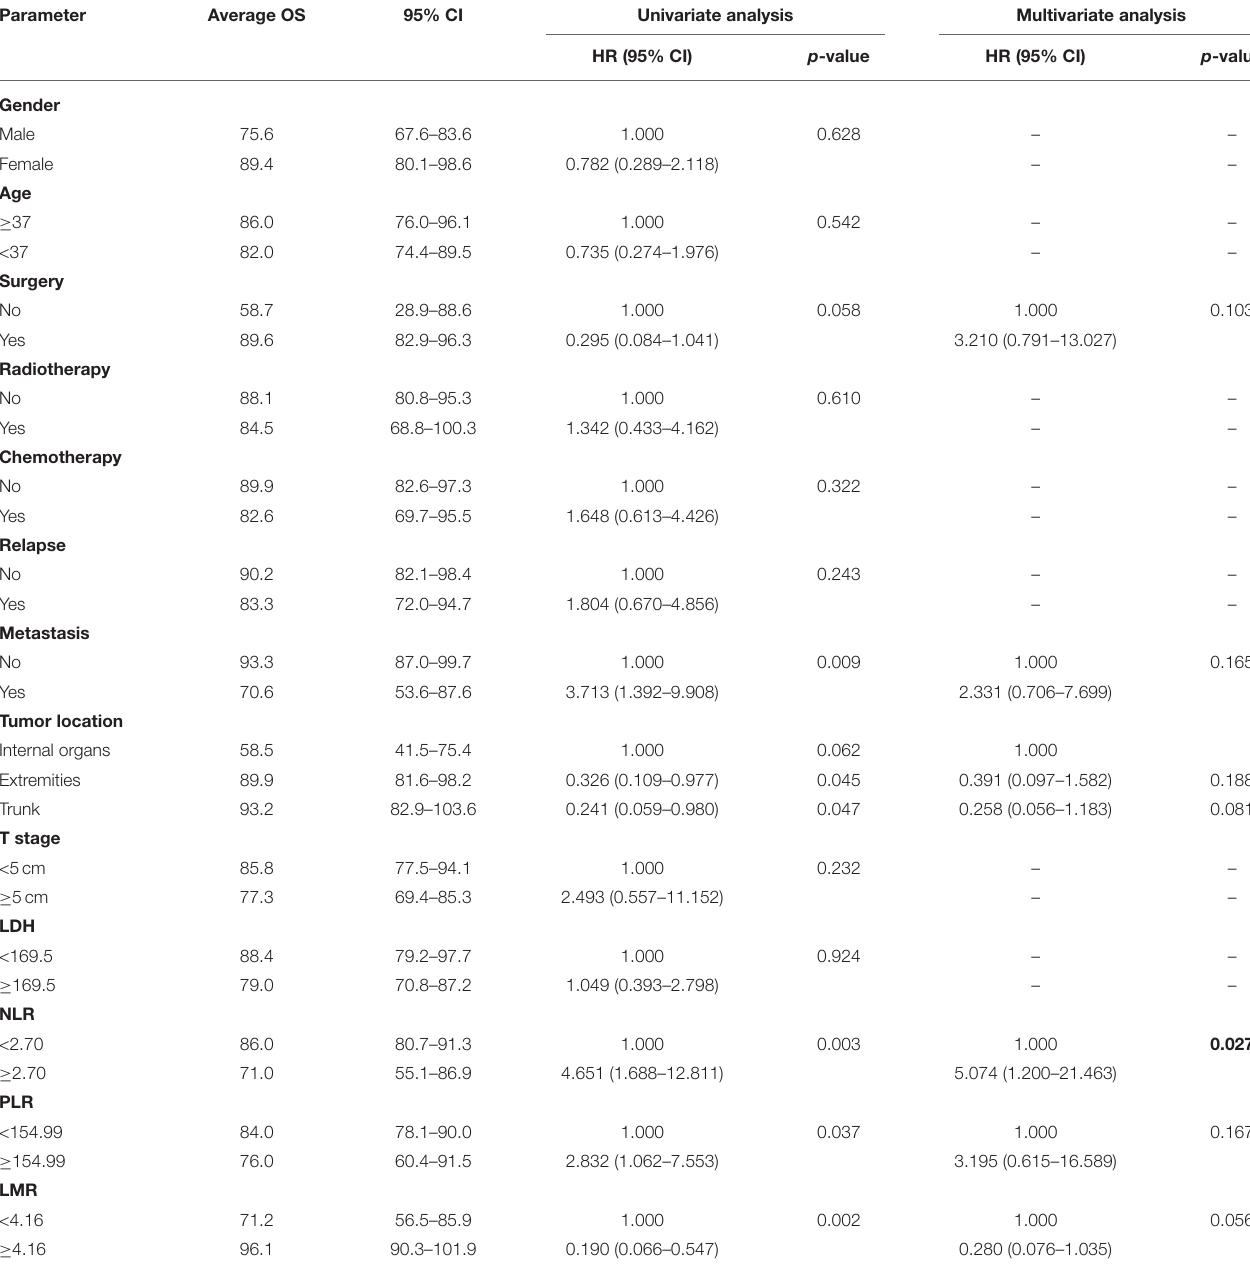
TABLE 2 | Summary of univariate and multivariate analysis for OS in patients with synovial sarcoma.